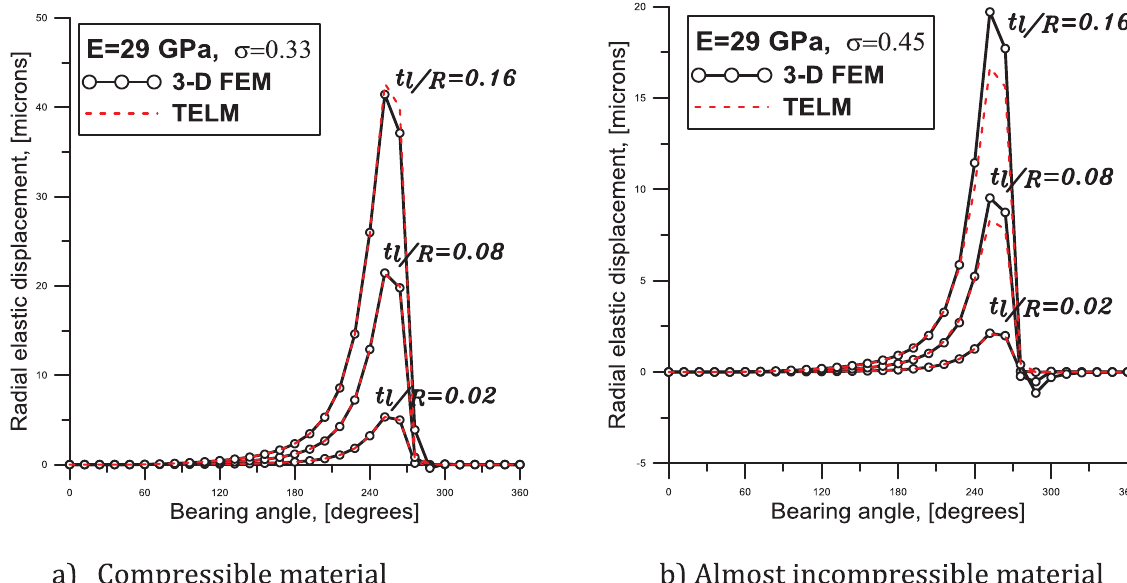
Fig. 5. Comparison of the radial displacement fi eld calculated by the simpli fi ed thin elastic liner model at the bearing-liner — fl uid fi lm interface with that obtained by the 3D fi nite element analysis.